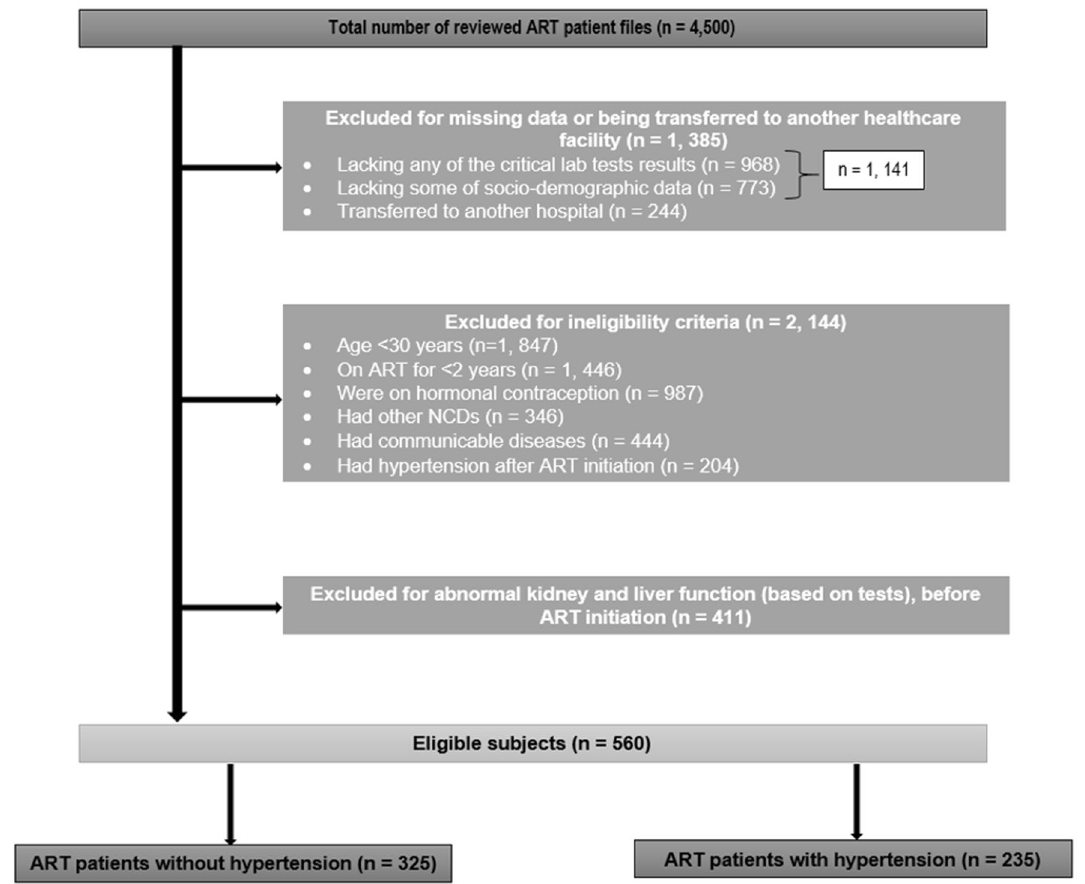
Figure 1. Flow chart for exclusion criteria and subject selection